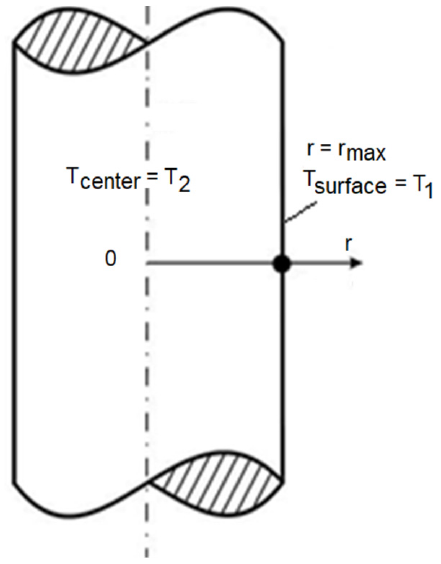
Figure 1. Temperature distribution inside an infinite rod.